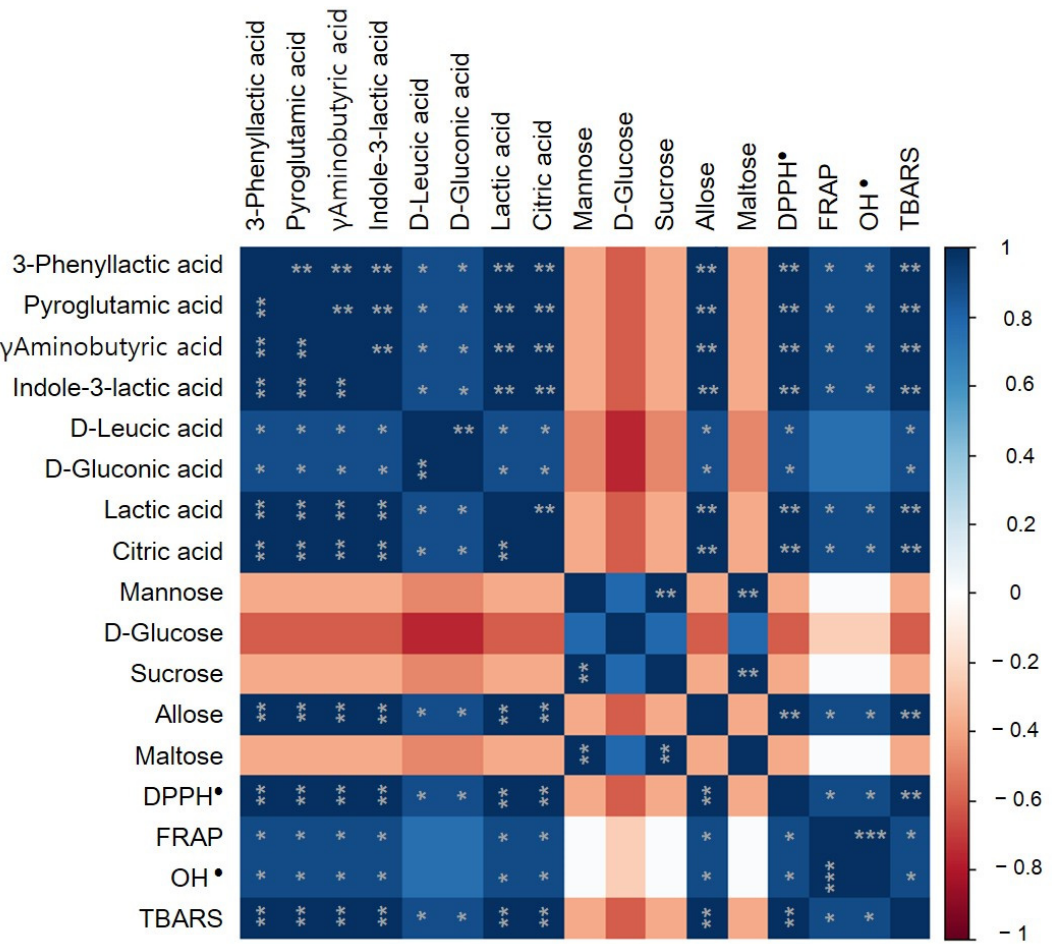
Figure 3. Heatmap. Distribution and concentration of phytochemicals among samples. Red boxes mean higher concentrations. Blue boxes mean lower concentrations.